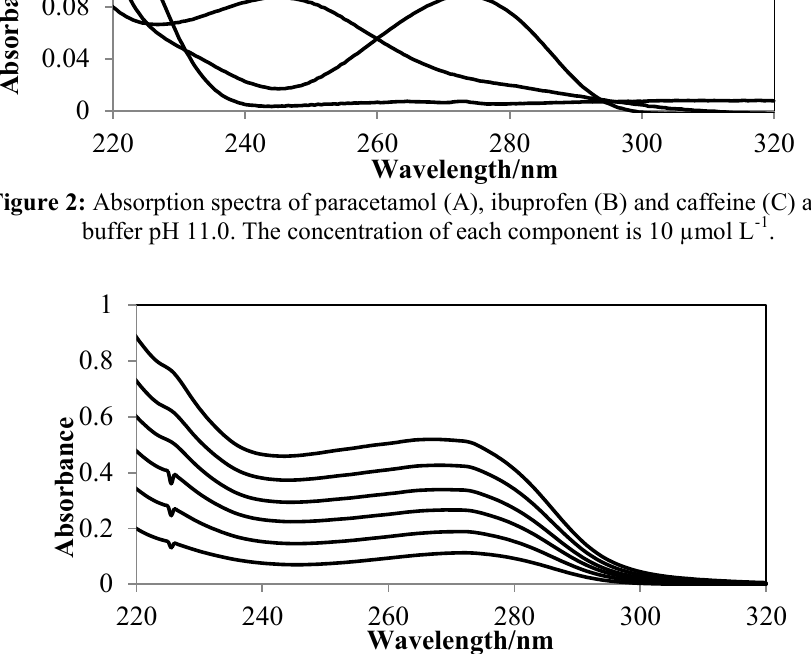
Figure 3: The spectra of the ternary mixture after addition of standards PAR, IBU and CAF in the same mole ratios in the concentration range of 10-60 µmol L -1 for spectra 1-6. The initial solution contains a ternary mixture of PAR (10 µmol L -1 ), IBU (10 µmol L -1 ) and caffeine (10 µmol L -1 ).